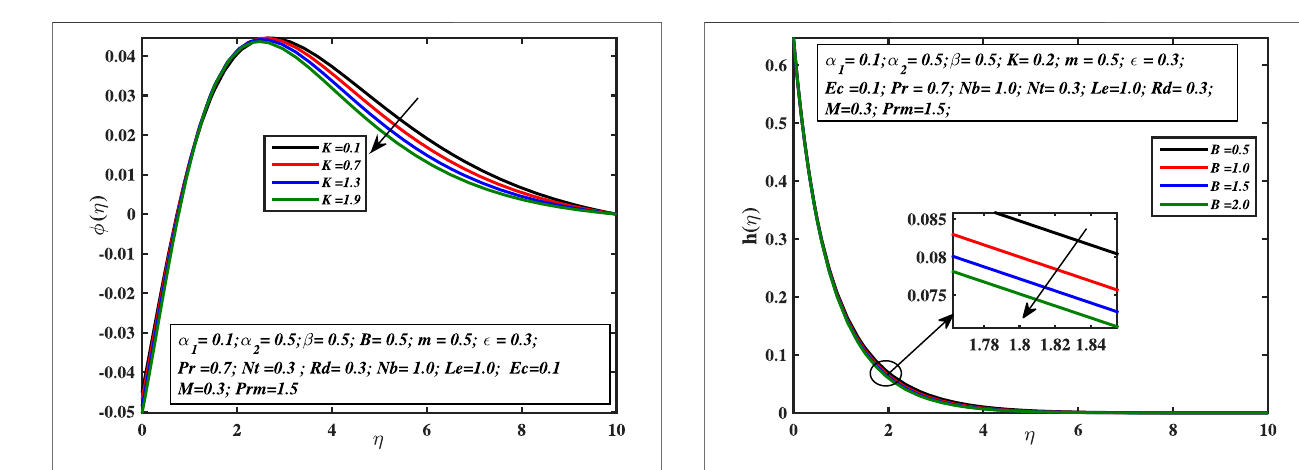
FIGURE 18 | Effect of B on the h ( η ) pro fi